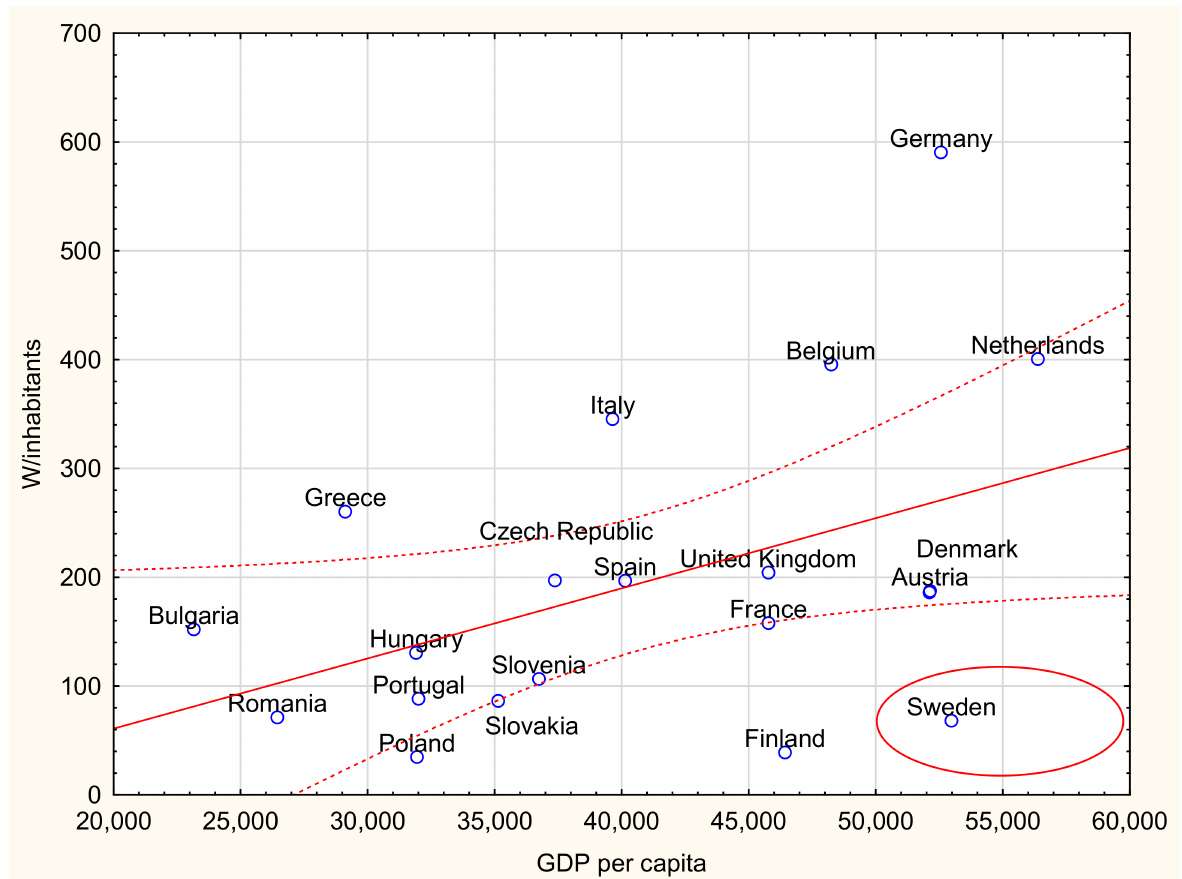
Figure 6. Relationship between GDP/per capita and W/inhabitant of photovoltaic capacity for the countries analysed. Source: Authors’ own